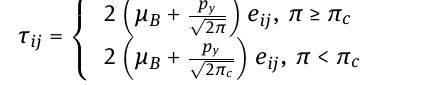
isothermal sphere and the fluid are maintained initially at the same temperature. Instantaneously they are raised to a temperature T > T ∞ i.e. the ambient temperature of the w fluid which remains unchanged. The appropriate constitu- tive equations for the Casson non-Newtonian model